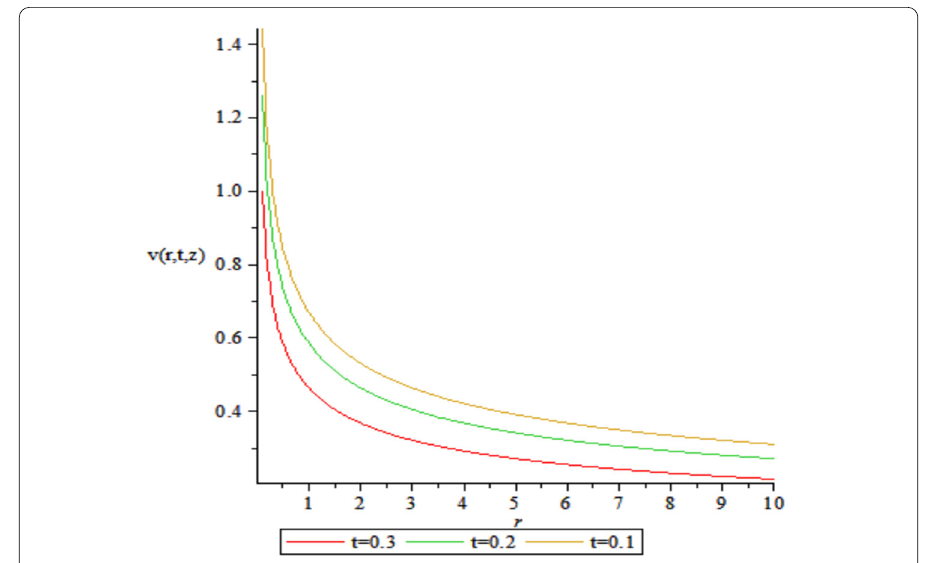
Figure 10 Velocity component v ( r , t , z ) at c 2 = 1